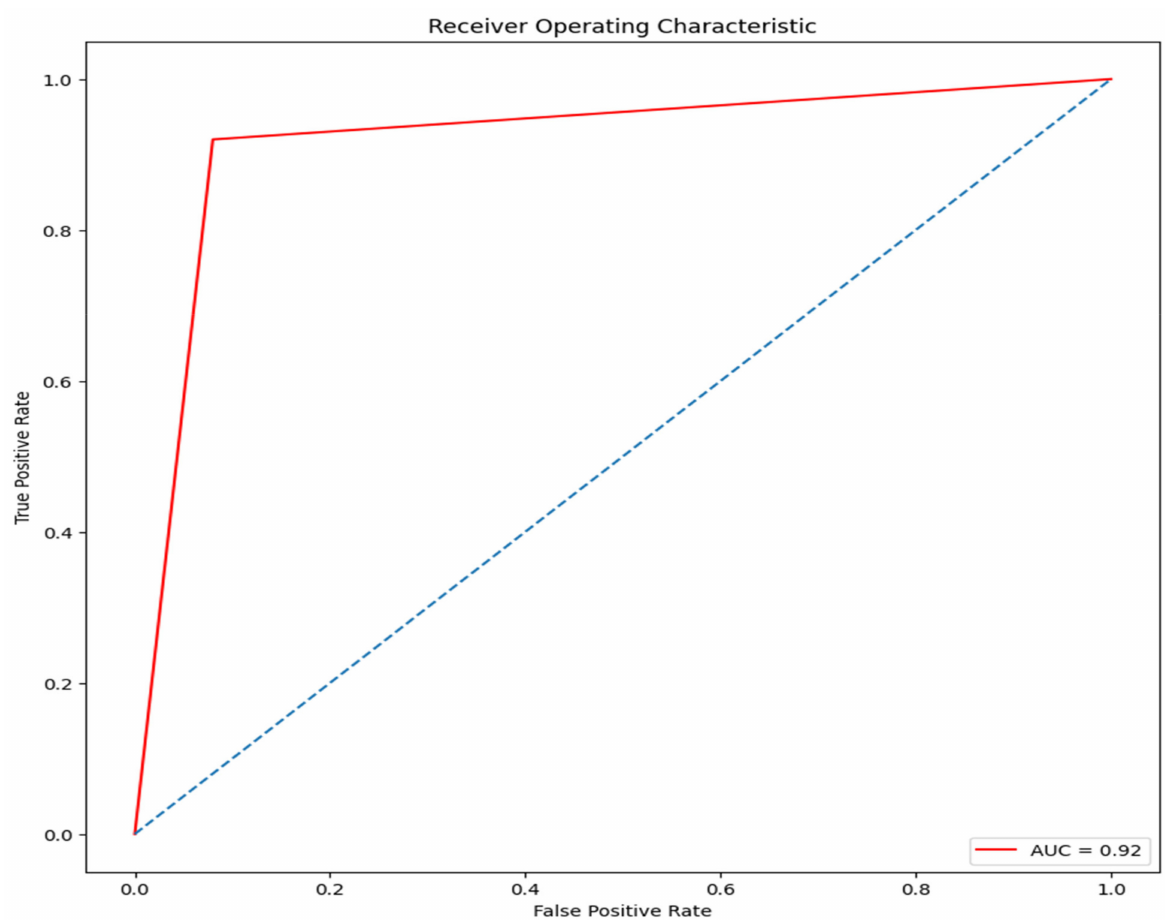
Figure 18. ROC of MobileNet